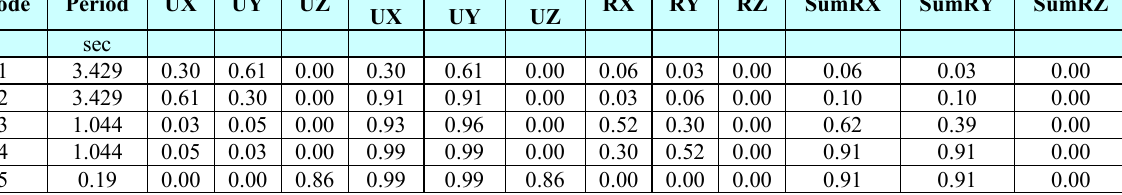
TABLE 1.2 B : Modal Participating Mass